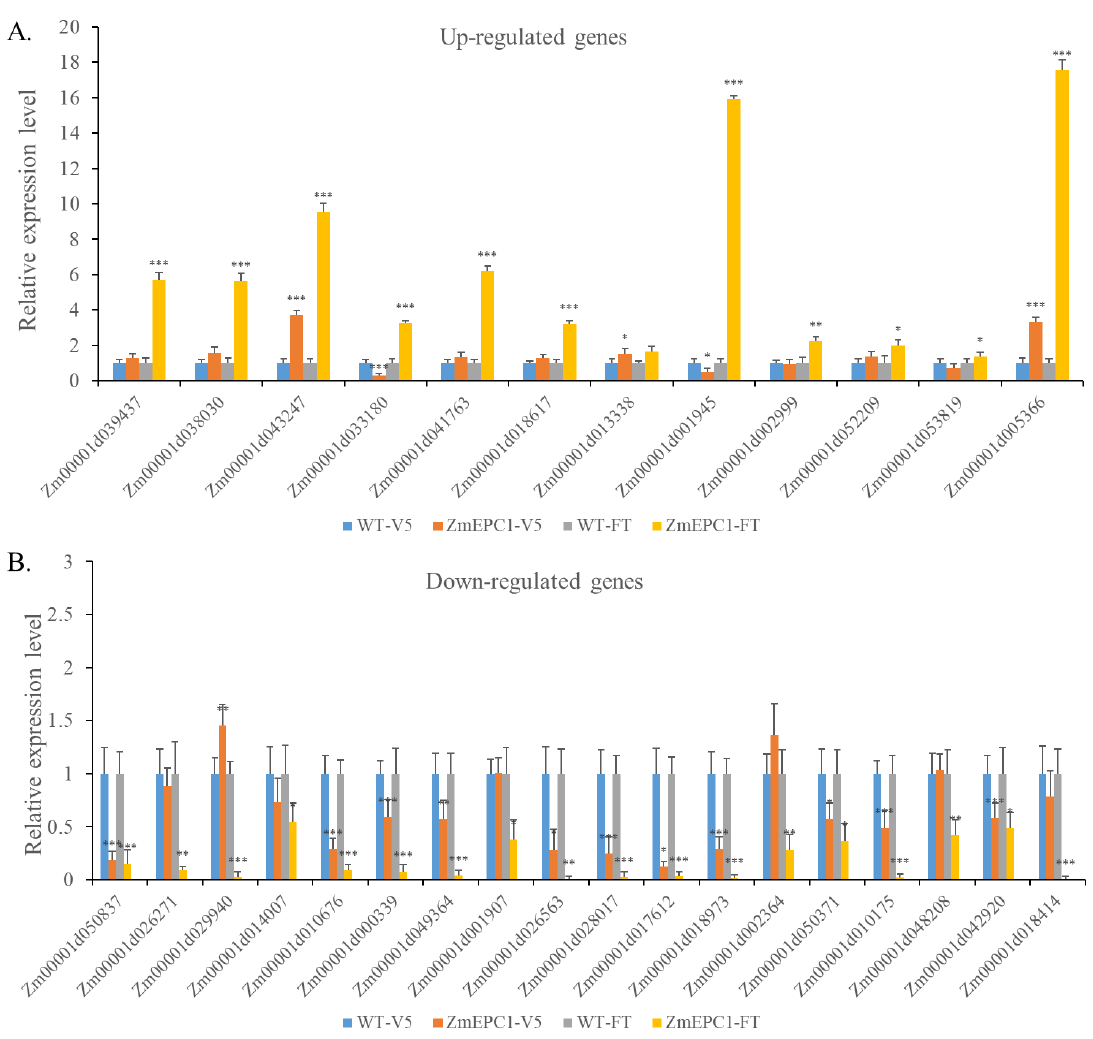
Figure 7. RT-qPCR analysis for the major DEGs between ZmEPC1 and the wild type. ( A ). RT-qPCR analysis for up-regulated DEGs at V5 and FT period; ( B ). RT-qPCR analysis for down-regulated DEGs at V5 and FT period. *, **, *** represent the difference significant level at p < 0.05, p < 0.01, p < 0.001, respectively.